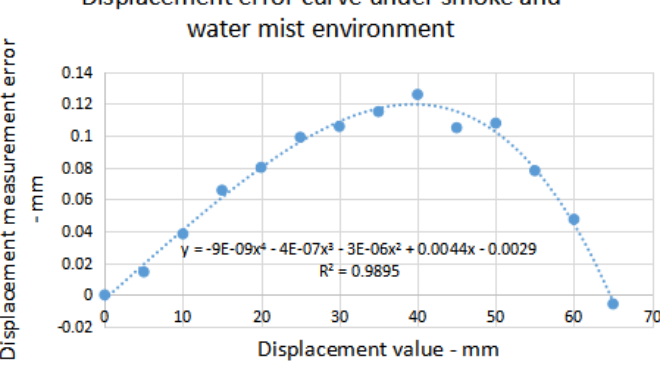
Figure 23. Displacement error curve under smoke and water mist environment.